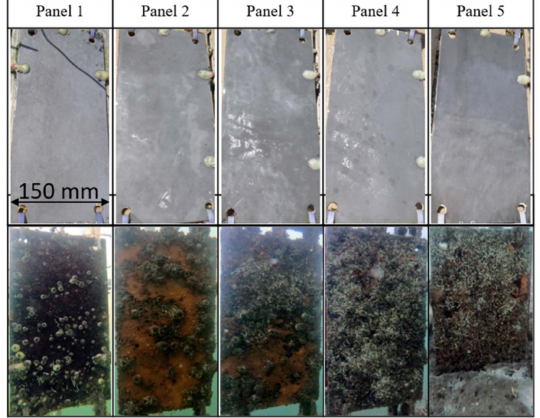
Figure 5. Clean ( top ) and previously fouled and corroded ( bottom )